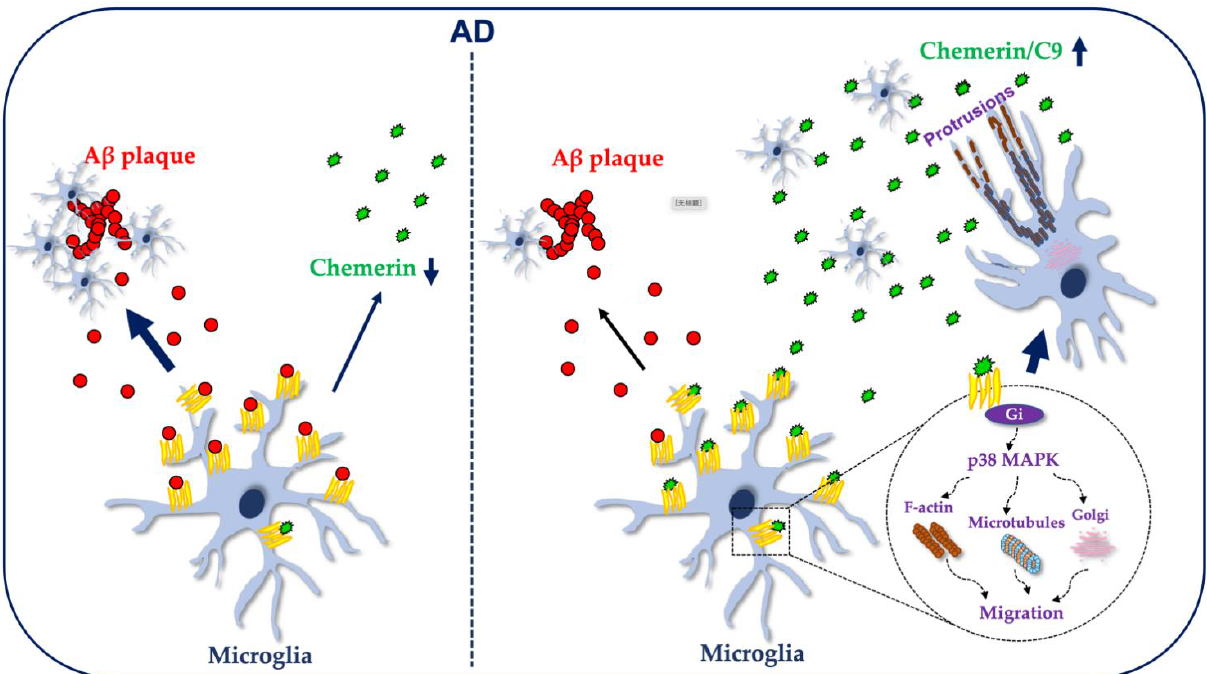
Figure 7. Schematic representation of the involvement of the chemerin/CMKLR1 axis in the recruit- ment of microglia to Aβ plaques. Under AD pathological conditions, the chemerin/CMKLR1 axis is weakened and the Aβ/CMKLR1 axis is overactivated, which leads to the migration and recruitment of microglial cells to Aβ plaques. Strengthening the chemerin/CMKLR1 axis promotes the migration and polarization of microglia by inducing actin filament and microtubule remodeling, and Golgi reorientation. p38 MAPK pathway activation serves to promote the chemerin/CMKLR1 axis on the migration and polarization of microglia.